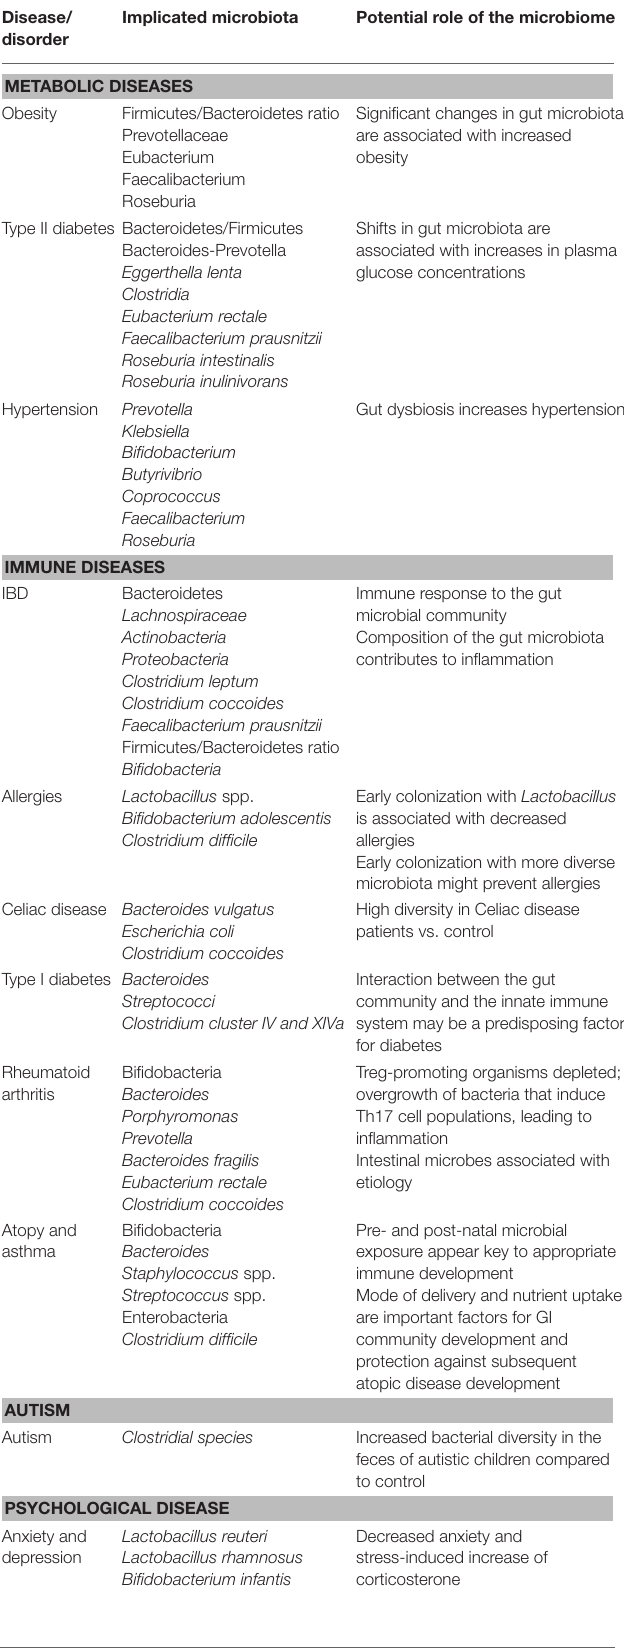
TABLE 1 | Effect of the gut microbiota on human